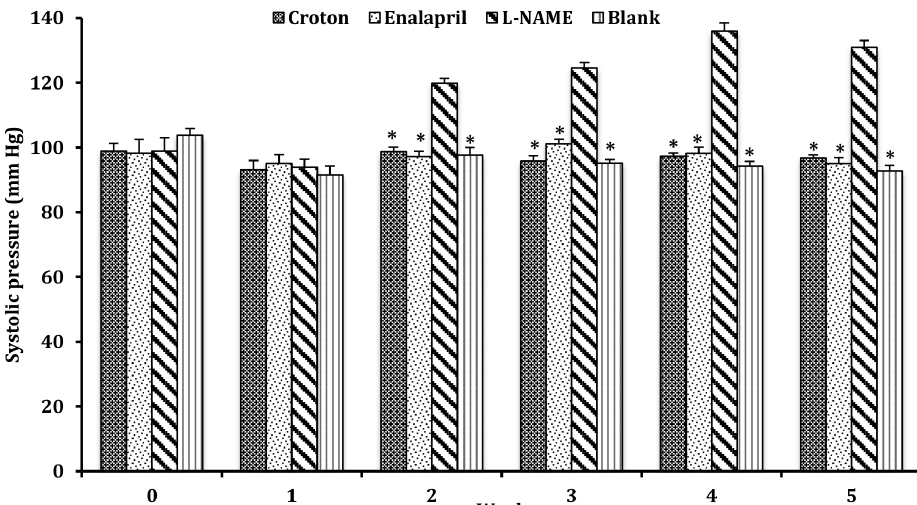
FIGURE 1 - Values of systolic blood pressure in Wistar rats treated with: (1) ethanolic extract of C. schiedeanus Schltd (200 mg/kg/day, p.o.) plus L-NAME (10 mg/kg, i.p.), (2) enalapril (reference drug, 10 mg/kg/day, p.o.) plus L-NAME (10 mg/kg, i.p.), (3) vehicle (control, olive oil 0.1 mL/100 g, p.o.) plus L-NAME (10 mg/kg, i.p.) and (4) vehicle (blank, olive oil 0.1 mL/100 g, p.o.). Results are expressed as means ± S.E.M. *p<0.05 with respect to the control group.